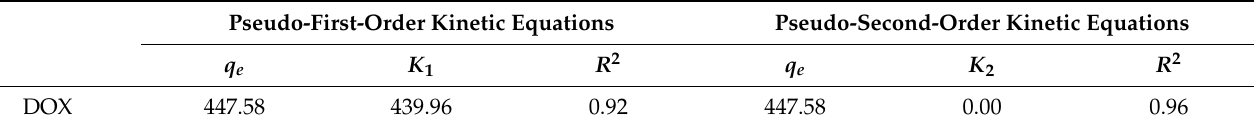
Table 2. Pseudo-first-order and pseudo-second-order adsorption kinetic constants.